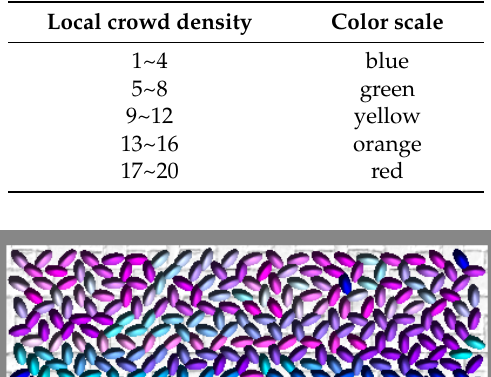
Table 3. Mapping of local crowd density and color scale.